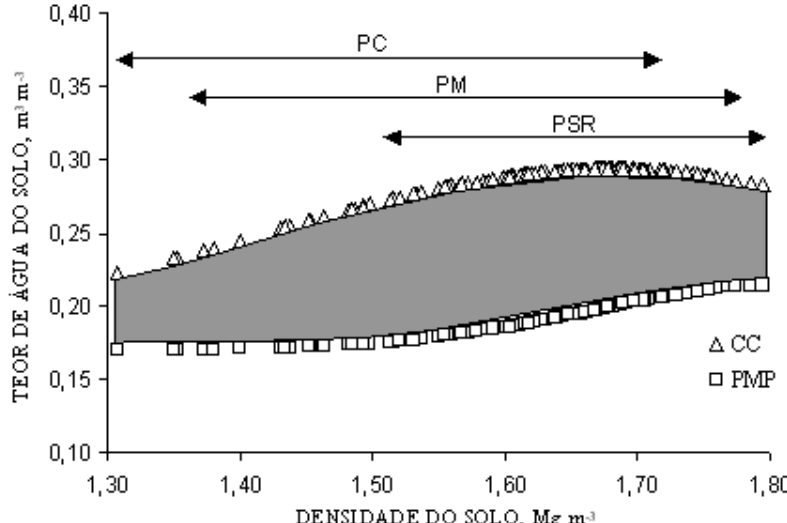
Figura 1. Teor de água no potencial correspondente à capacidade de campo (CC) e ponto de murcha permanente (PMP) em função de Ds. A área hachurada entre CC e PMP representa a água disponível (AD). As setas indicam os intervalos de Ds nos sistemas de preparo PSR = plantio sem revolvimento; PM = preparo mínimo e PC = preparo convencional do